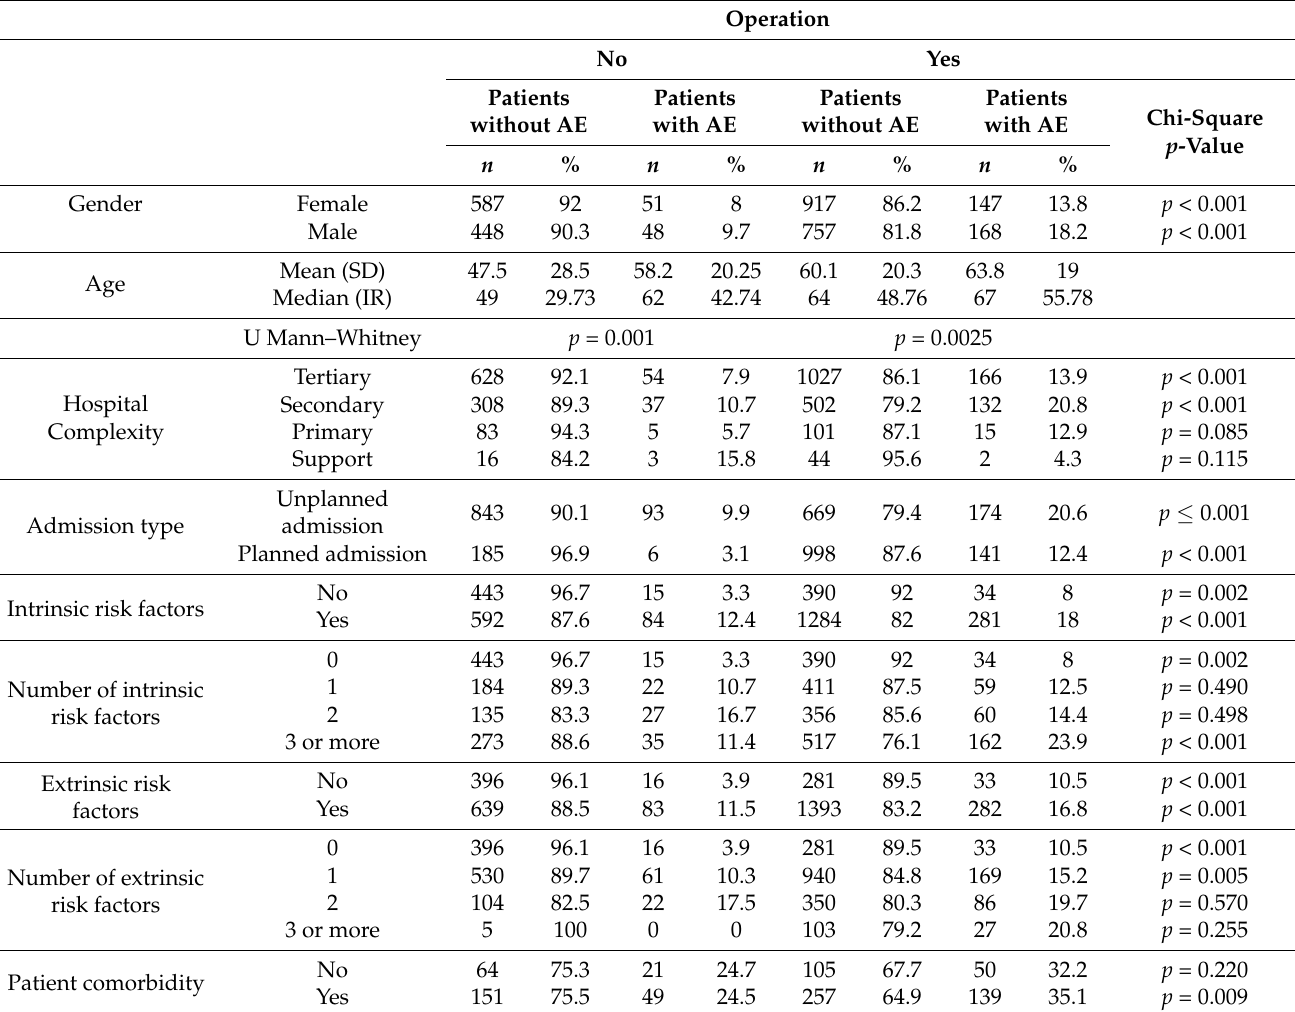
Table 3. Characteristics of the study population of operated and non-operated patients with and without